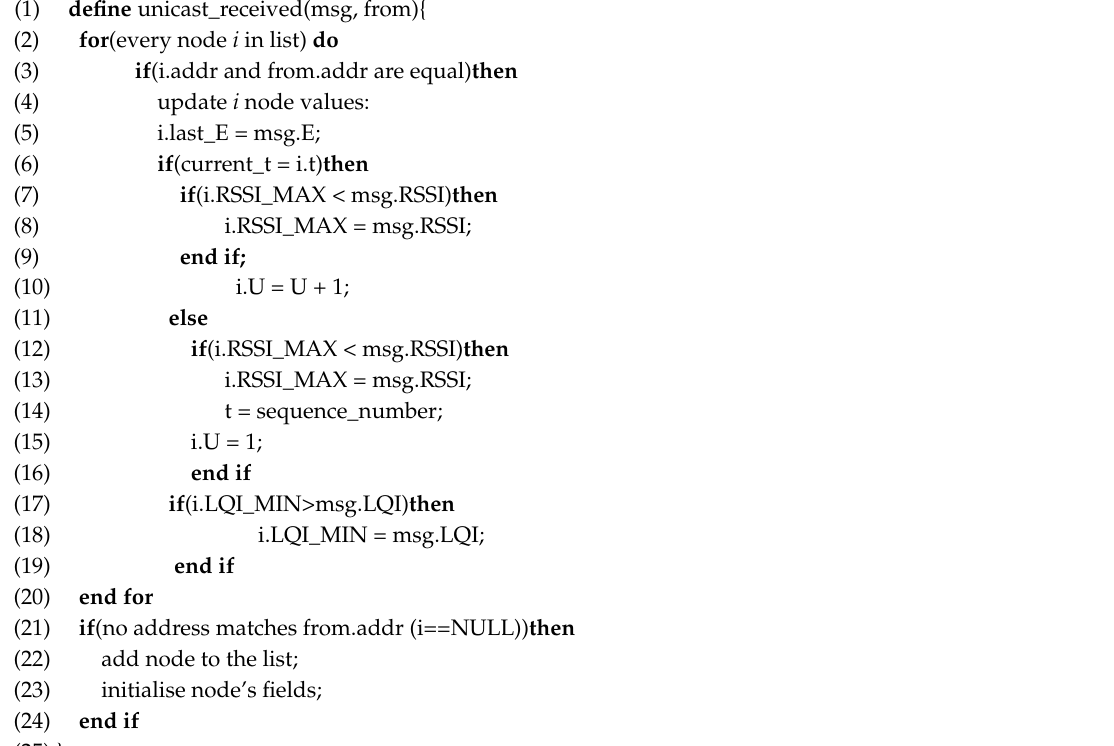
Algorithm 3 . UAV unicast message received from sensor node function